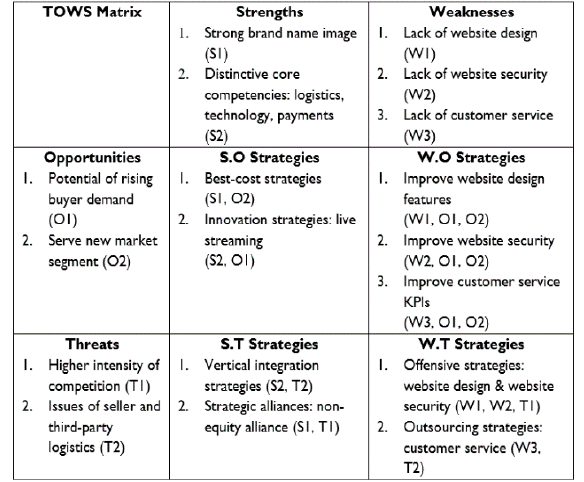
Figure 3: TOWS Matrix for Online Shopping